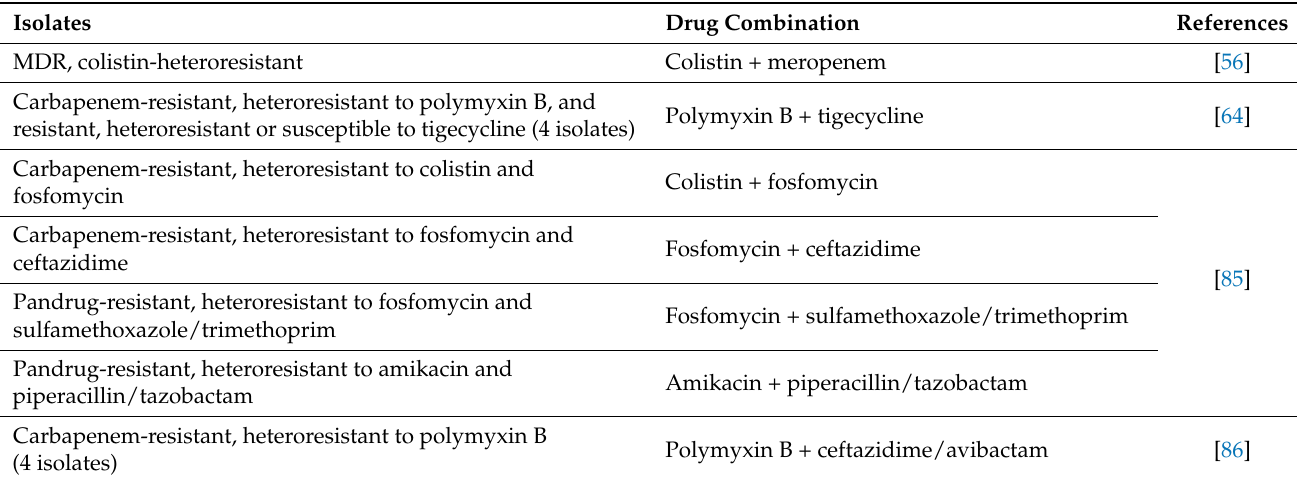
Table 2. Drug combinations effective against heteroresistant K. pneumonia isolates. Drug